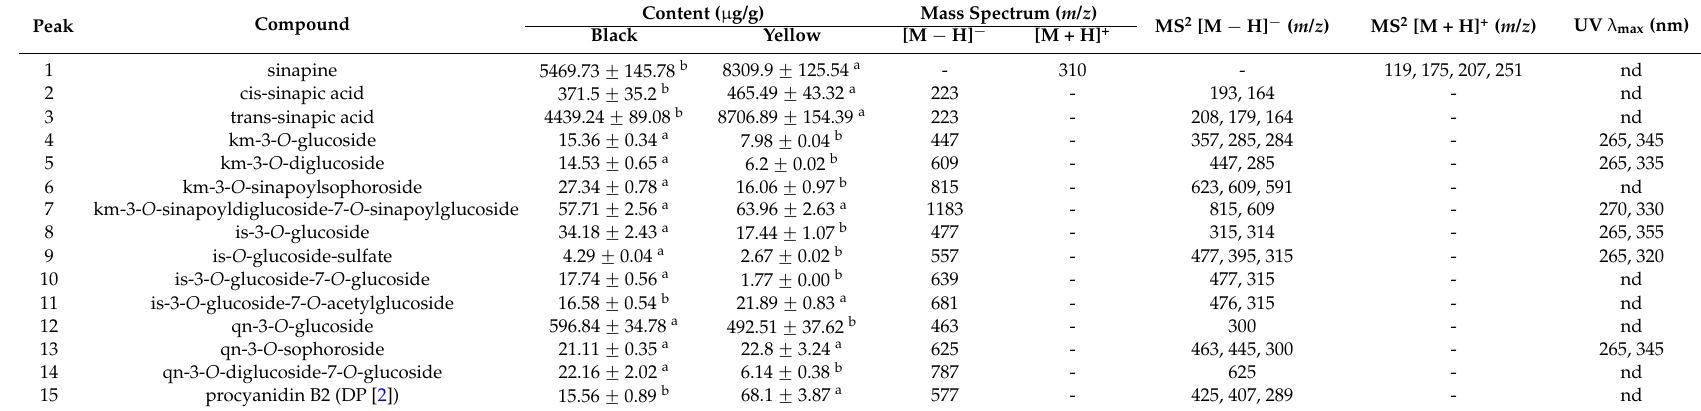
Table 4. LC/MS data of tentatively identified polyphenolics in meal of black- and yellow-seeded B. napus and their quantitative analysis using DAD at 280 and 330